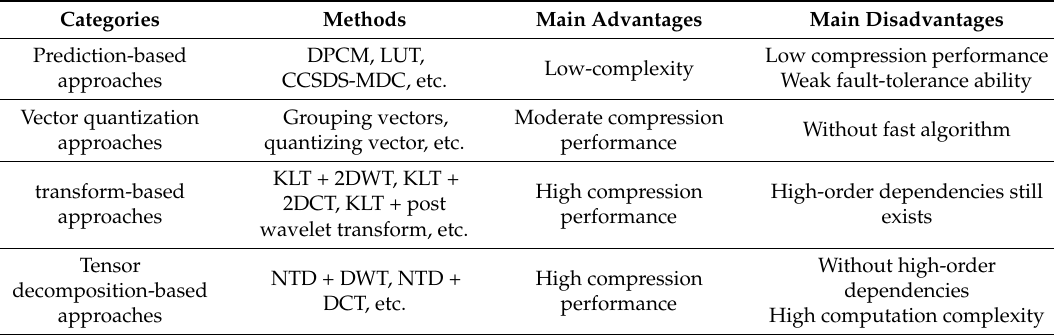
Table 1. Compression methods for multispectral